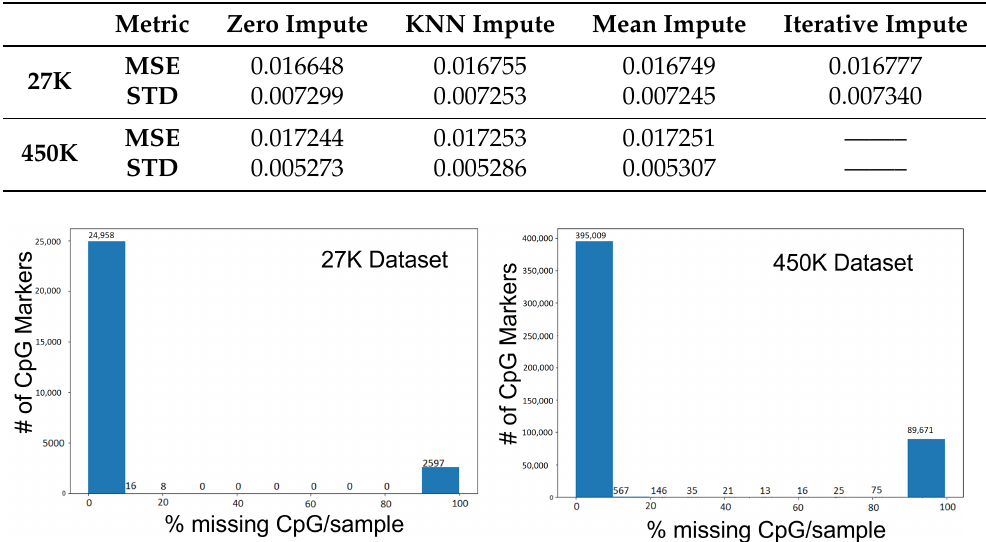
Table 2. Mean Squared Error (MSE) and Standard Deviation (STD) for the imputed results using the